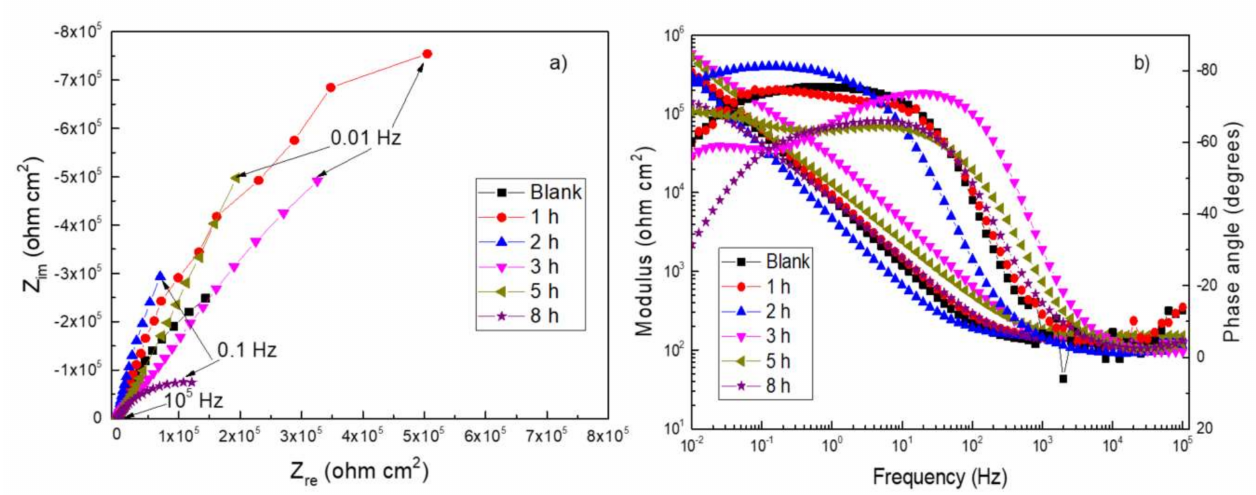
Figure 6. Effect of the oxidizing time on the ( a ) Nyquist and ( b ) Bode diagrams for Ti6Al4V alloy corroded in artificial saliva solution during 100